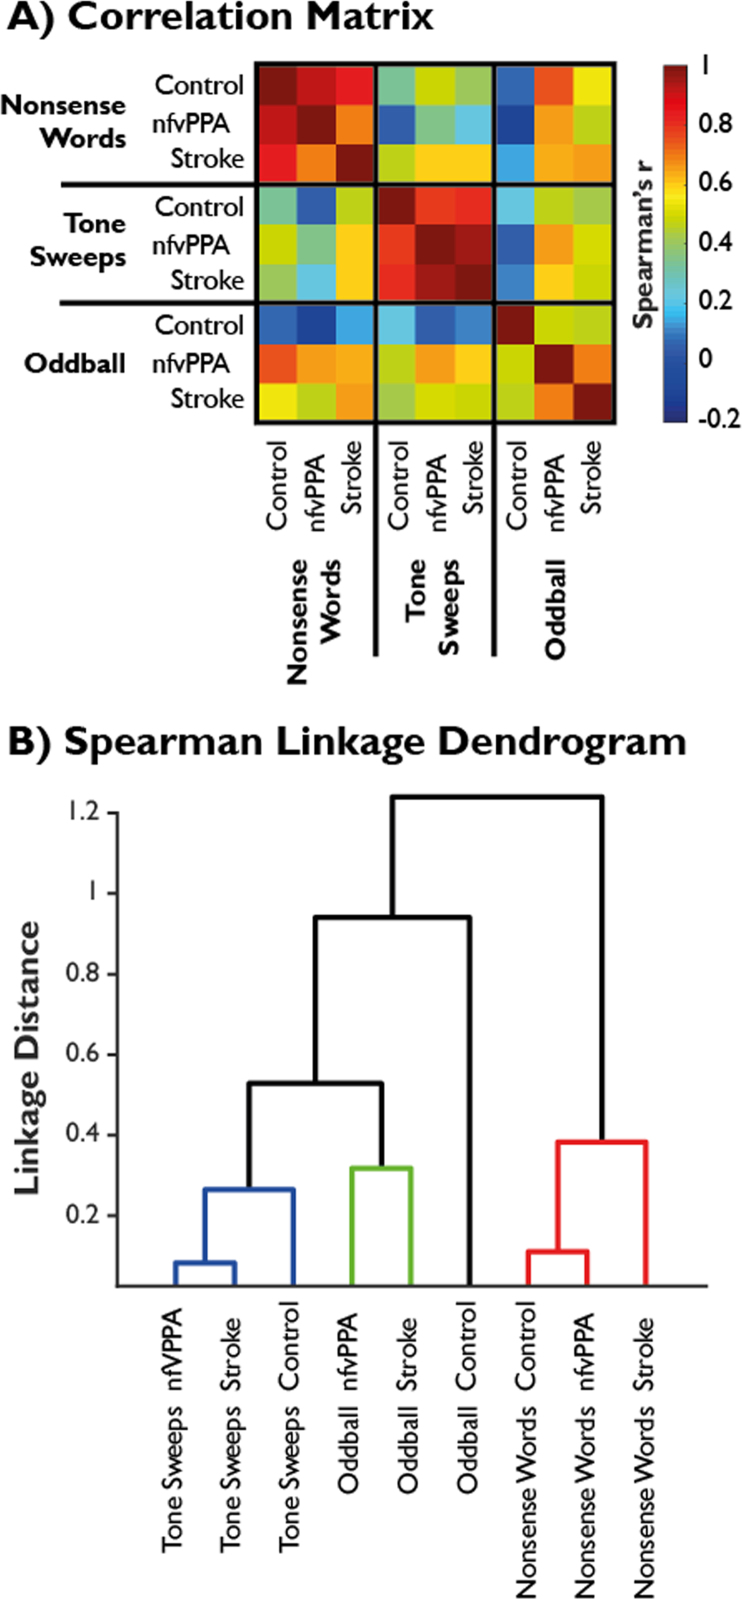
A) Spearman rank-order correlation matrices. B) Linkage based on hierarchical cluster analysis of Spearman correlations. Three clusters emerge with a linkage distance cutoff of 0.5, and are indicated in colour groupings (blue, green and red). (For interpretation of the references to color in this figure legend, the reader is referred to the web version of this article.)